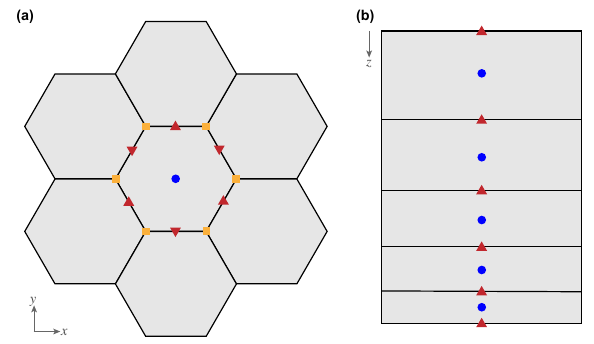
Figure 1. MALI grids. (a) Horizontal grid with cell center (blue cir- cles), edge midpoint (red triangles), and vertices (orange squares) identified for the center cell. Scalar fields ( H , T ) are located at cell centers. Advective velocities ( u n ) and fluxes are located at cell edges. (b) Vertical grid with layer midpoints (blue circles) and layer interfaces (red triangles) identified. Scalar fields ( H , T ) are located at layer midpoints. Fluxes are located at layer